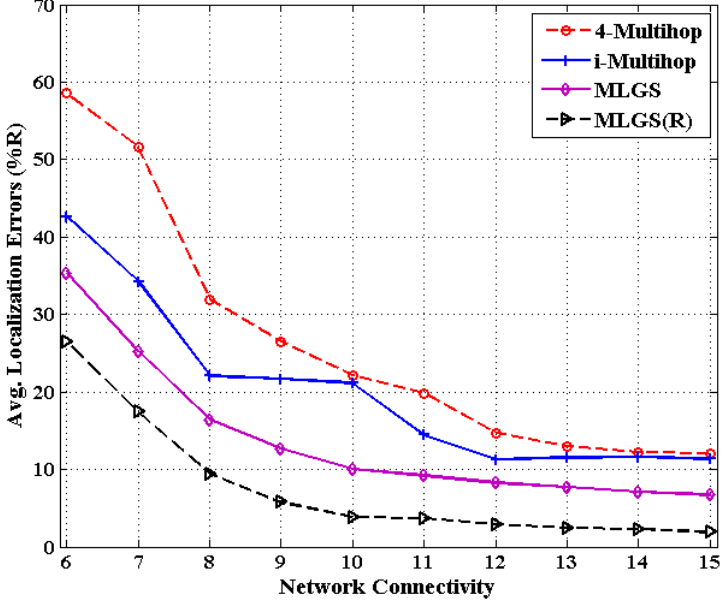
Figure 15. Average localization error versus network connectivity (anisotropic network).